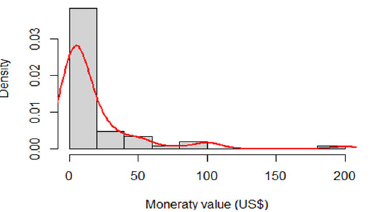
Fig. 3 Vickery auction bid value distribution: Monetary bid of participants in exchange for GPS data. Table 4 Average monetary value of the GPS data among the ‘ follow-up proposal ’